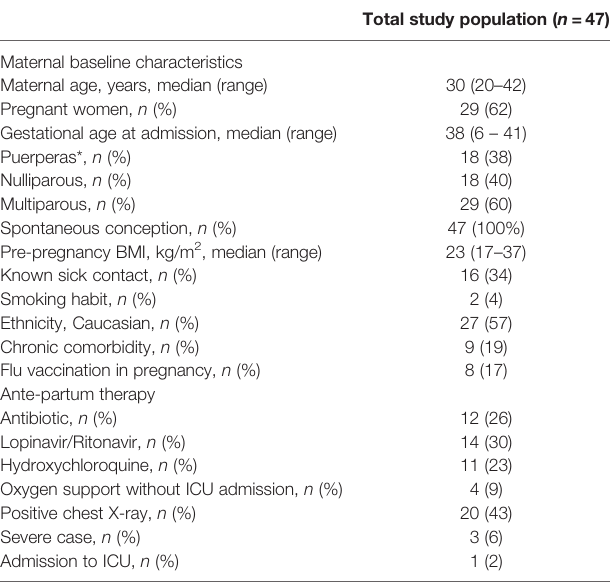
TABLE 1 | Baseline characteristics of the study population on